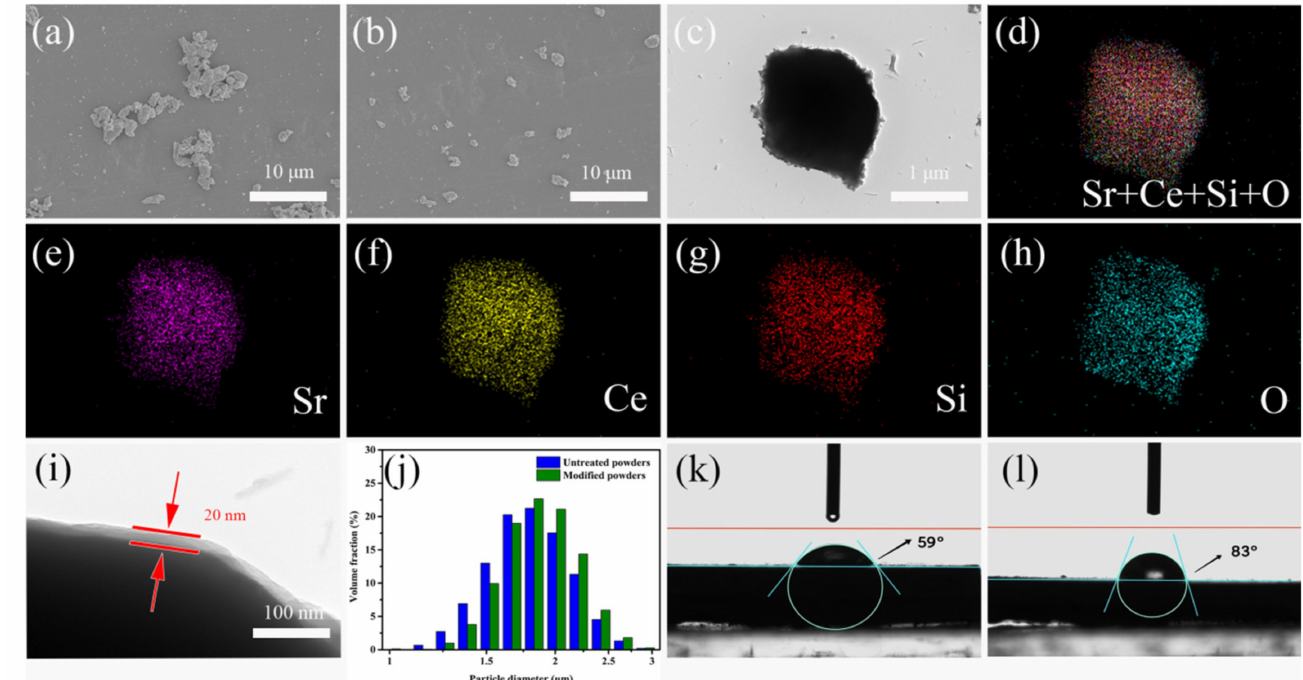
Figure 1. ( a ) SEM image of untreated Sr 2 CeO 4 ; ( b ) modified Sr 2 CeO 4 @SiO 2 ; ( c ) TEM image of modified Sr 2 CeO 4 @SiO 2 ; ( d – h ) corresponding electron microscopy images of modified Sr 2 CeO 4 @SiO 2 ; ( i ) TEM image of SiO 2 shell; ( j ) the particle size distribution; ( k ) the hydrophobic angle of untreated Sr 2 CeO 4 ; ( l ) modified Sr 2 CeO 4 @SiO 2